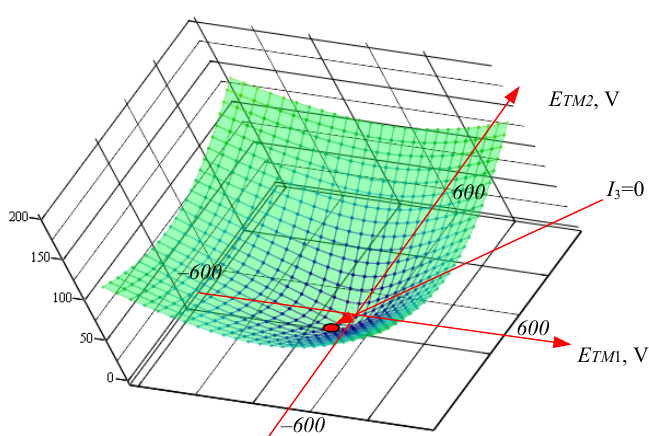
Figure 16. Change in current I 3 under combined control mode.